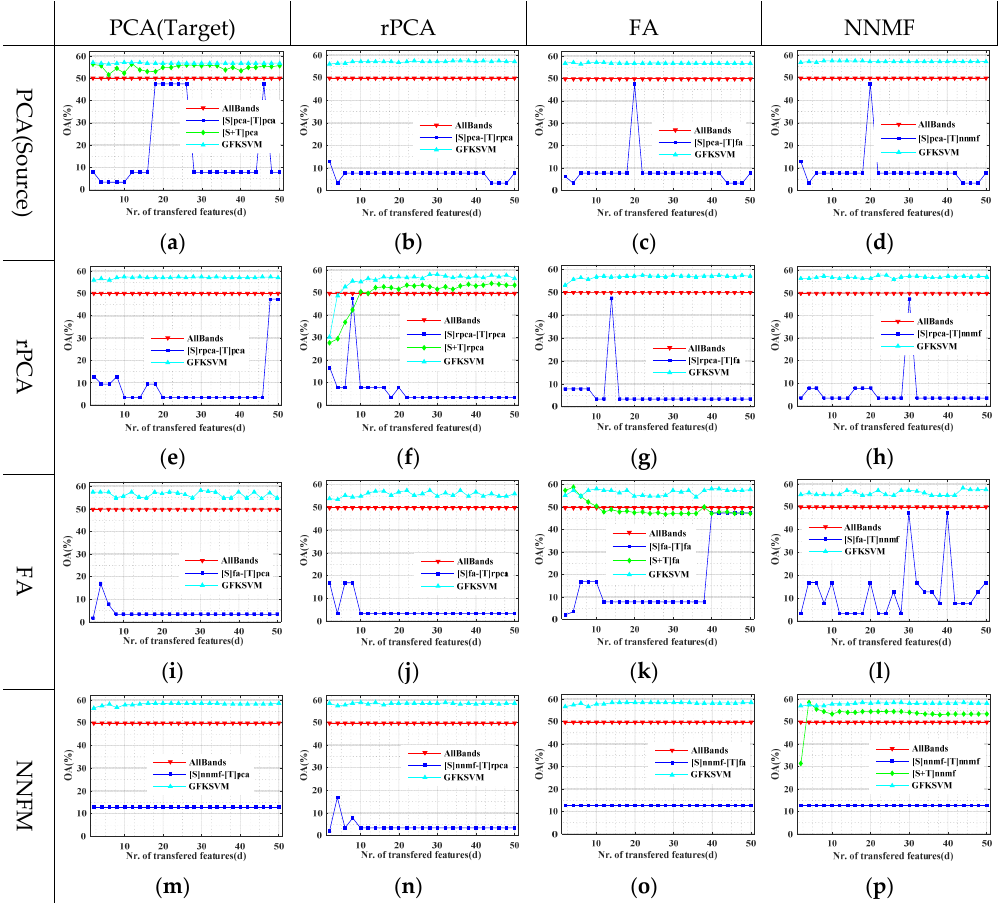
Figure 12. Classification accuracy curves for GFKSVM with various subspace feature transfer approaches on ROSIS data (Center → University). ( a ) PCA-PCA; ( b ) PCA-rPCA; ( c ) PCA-FA; ( d ) PCA- NNMF; ( e ) rPCA-PCA; ( f ) rPCA-rPCA; ( g ) rPCA-FA; ( h ) rPCA-NNFM; ( i ) FA-PCA; ( j ) FA-rPCA; ( k )